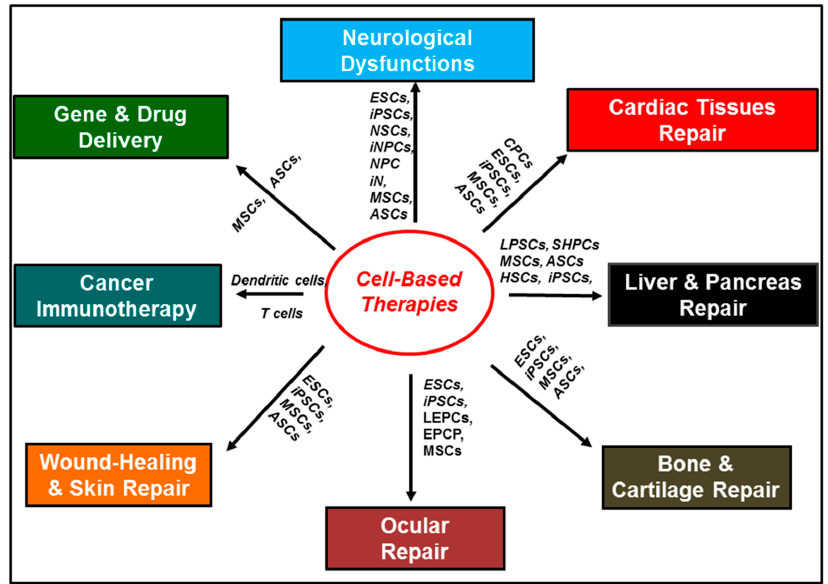
Figure 1. Schematic representing applications for cell-based therapies in regenerative medicine and in oncology. The following cell types are abbreviated in the figure: embryonic stem cells (ESCs); neural stem cells (NSCs); neural progenitor cells (NPCs); mesenchymal stem cells (MSCs); induced pluripotent stem cells (iPSC); induced neuronal cells (iN); induced neuronal progenitor cells (iNPCs); adipose-derived stem cells (ADSCs); embryonic germinal stem cells (EGC); endothelial progenitor cells (EPCs); cardiac progenitor cells (CPCs); lens epithelial progenitor cells (LEPCs); epithelial progenitor cells (EPCP); small hepatocytes-like progenitor cells (SHPCs); liver stem cells/progenitor cells (LPSCs); sinusoidal endothelial progenitor cells (SEPCs); hematopoietic stem cells (HSCs); and adipose stem cells (ASCs).